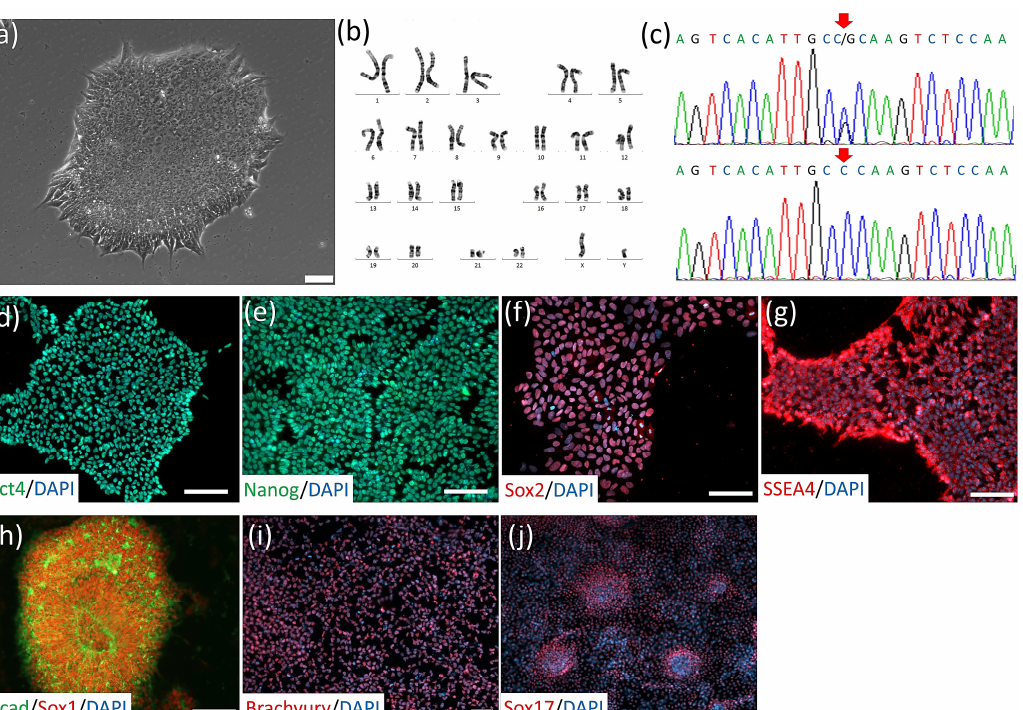
Figure 1. iPSC generation and SOD1 mutant site correction. ( a ) Morphology of SOD1 G85R ALS patient’s PBMC-derived iPSC clone. ( b ) Karyotype of SOD1 G85R iPSCs. ( c ) DNA sequencing of SOD1 G85R iPSCs (upper panel) and corrected SOD1 G85G iPSCs (lower panel). Mutant and corrected site are emphasized with arrows. ( d – g ) SOD1 G85R iPSC-expressed pluripotent stem cell-specific markers including Oct-4 ( d ), Nanog ( e ), Sox-2 ( f ), and SSEA4 ( g ). ( h – j ) In vitro differentiation of SOD1 G85R iPSCs into cell types with three germ layer cell markers including the ectoderm markers N-cadherin and Sox-1 ( h ), mesoderm marker Brachyury ( i ), and endoderm marker Sox-17 ( j ). Scale bar, 100 µ